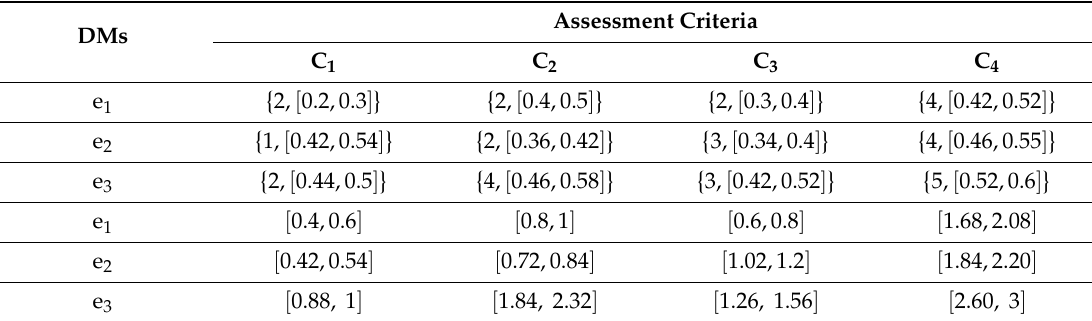
Table 2. Assessment of criteria weight matrix for RES selection.